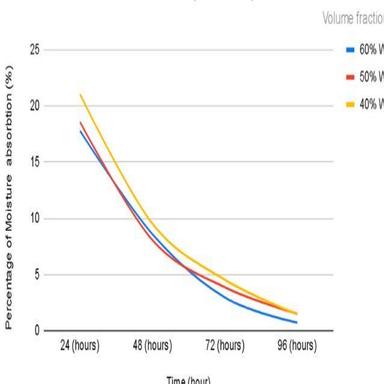
The effect of moisture content on volume fraction for Citrus limetta peel powder composites.